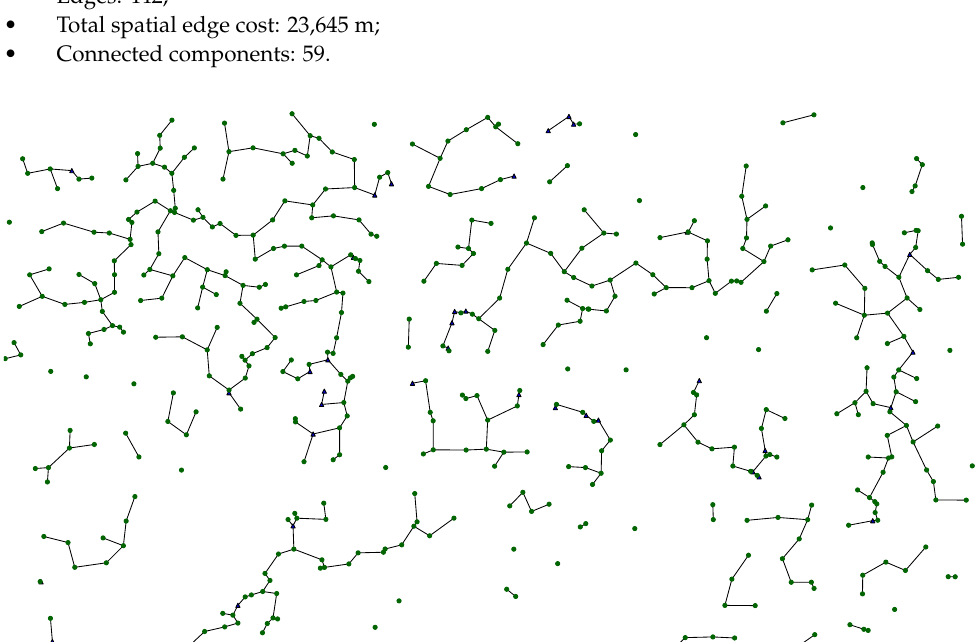
Figure 8. Minimum spanning forest of modeled static sensor network graph in the city center of Pozna´n on 27 November